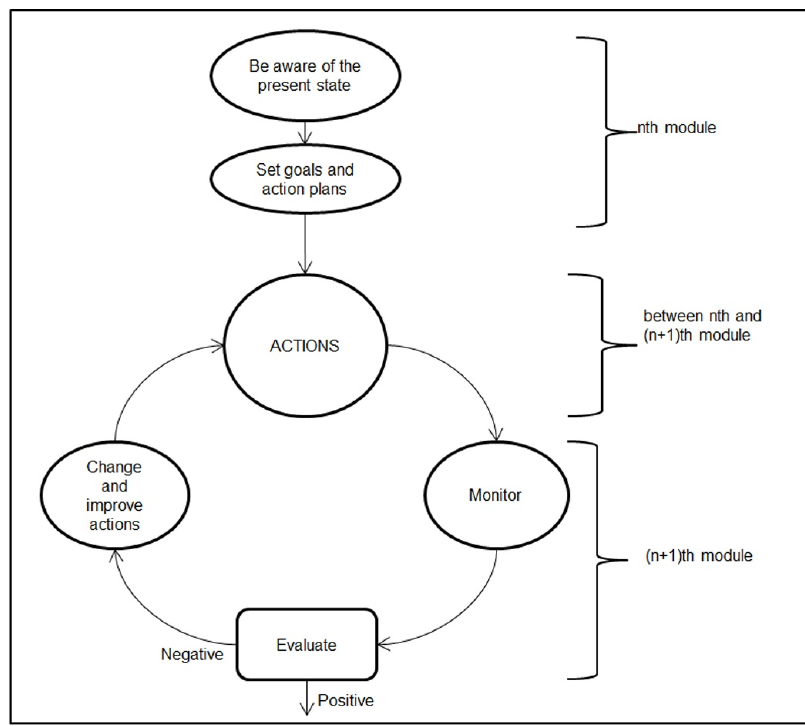
Figure 2. Structure of the training module.